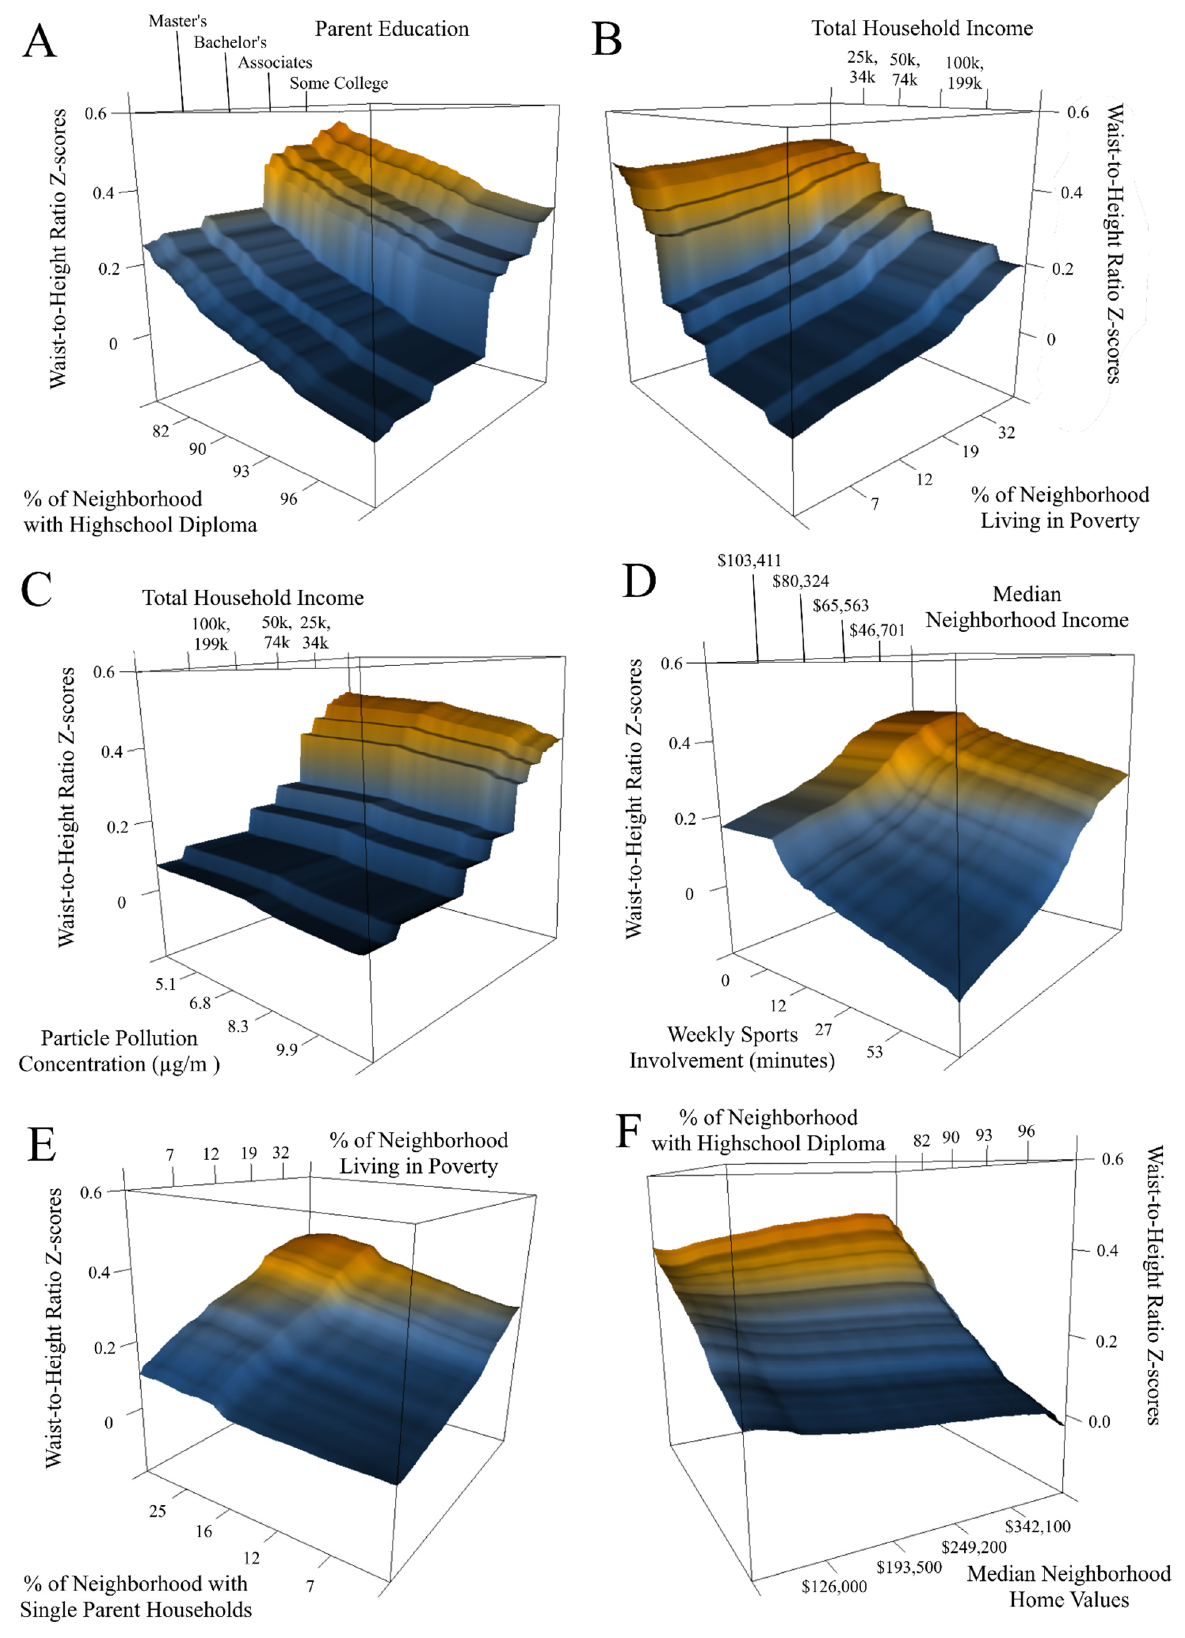
Figure 3. Feature interactions predicted waist-to-height ratio z-scores. 3d surface map showing waist-to-height ratio z-scores by quantiles of interacting features. The predicted waist-to-height ratio z-scores as a function of parent education level and % of neighborhood with a high school